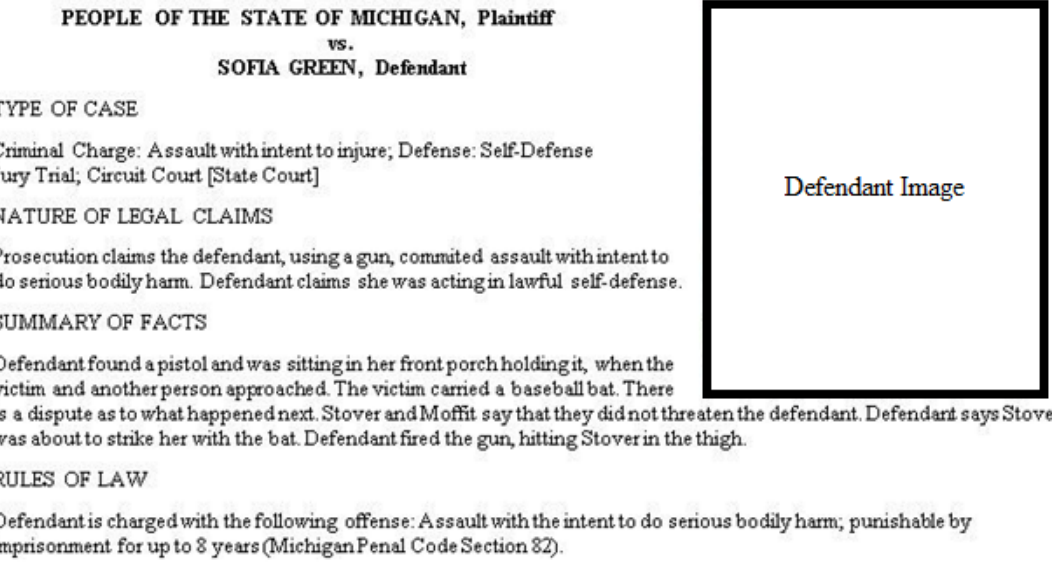
Figure A1. First trial vignette used in Study 1.